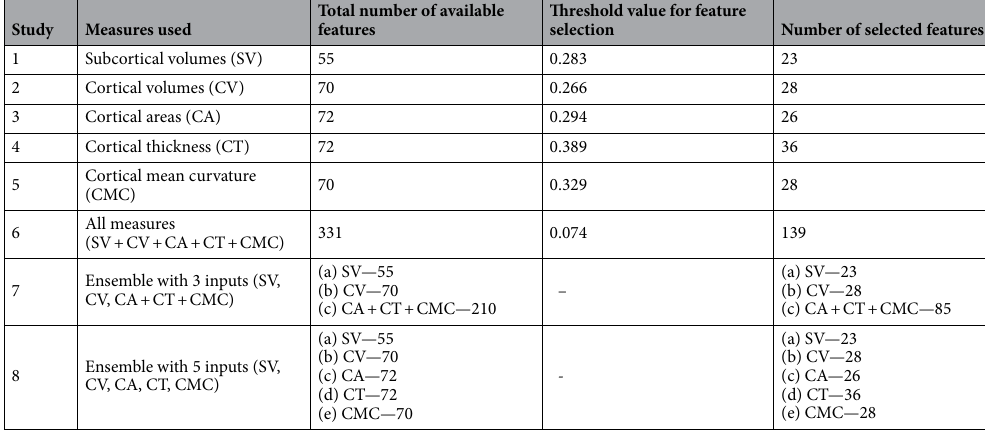
Table 1. Overview of analyses performed—measures, number of available features and selected number of features